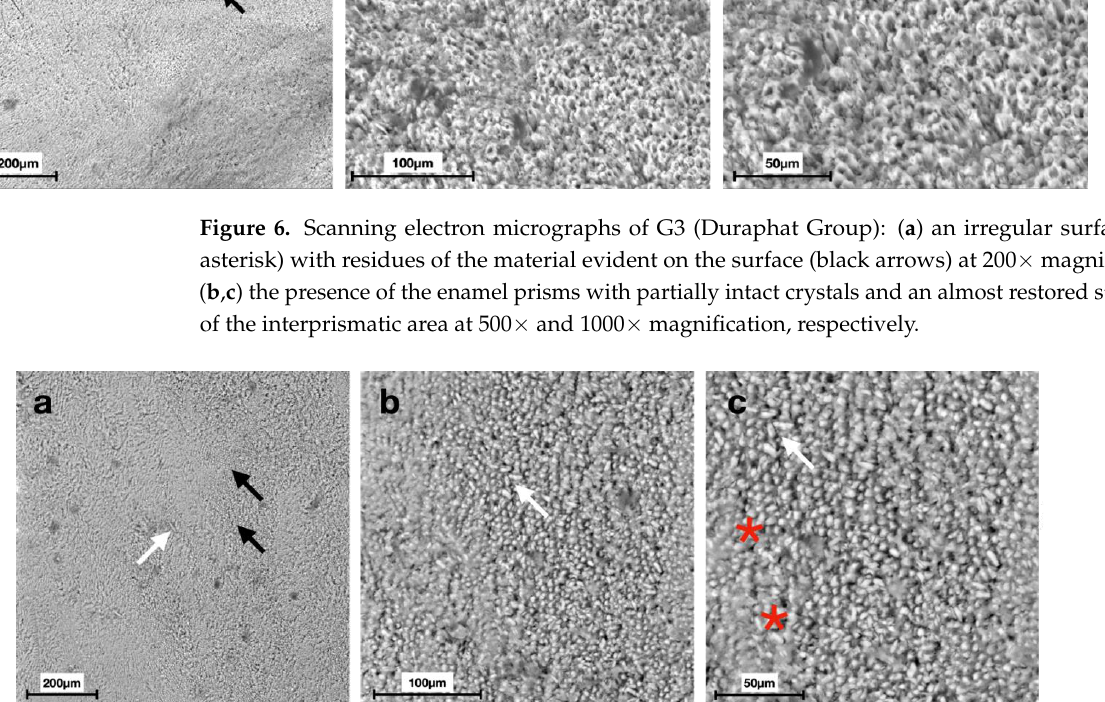
Figure 7. Scanning electron micrographs of G4 (Biosmalto Group): ( a ) a slight irregular surface of the enamel (black arrows), showing material residues on the surface (white arrow) at 200× magnification; ( b , c ) the irregular surface with a slight interprismatic dissolution (red asterisks) at 500× and 1000× magnification, respectively.